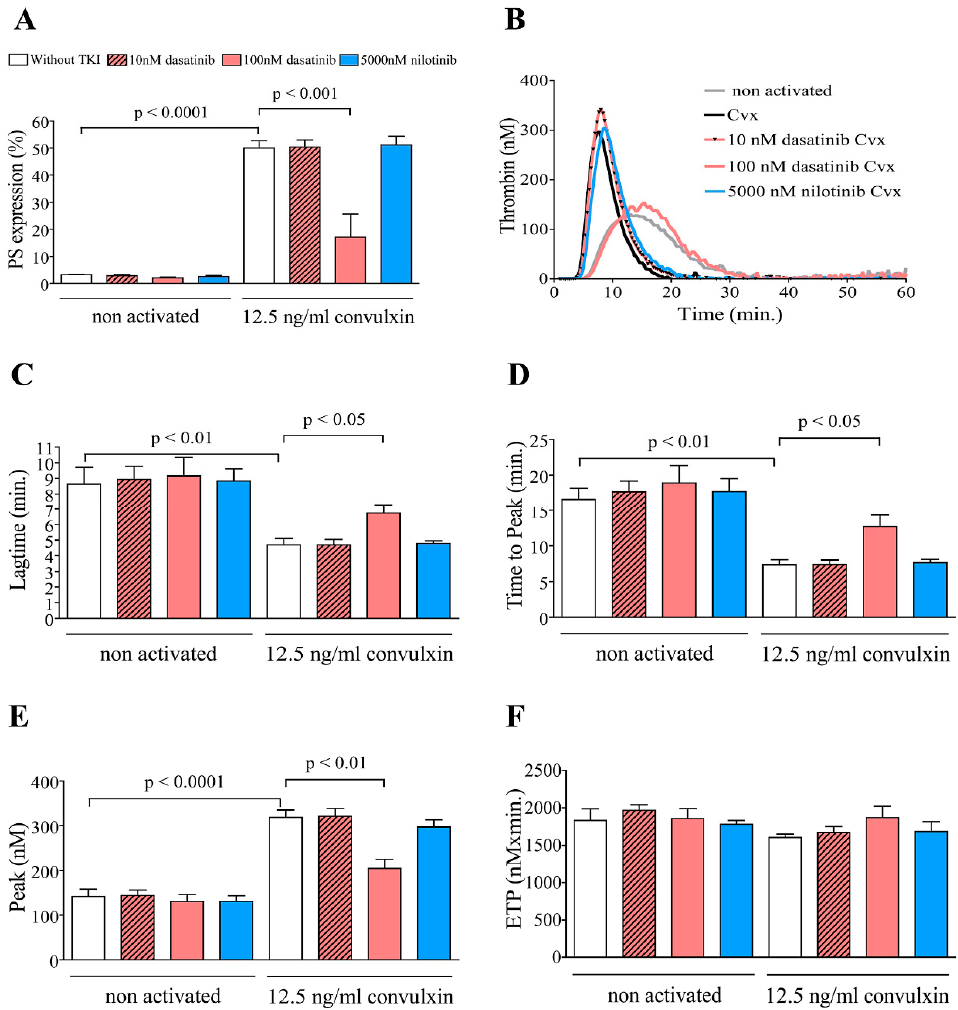
Figure 1. Dasatinib inhibits convulxin-induced procoagulant phosphatidylserine (PS) exposure